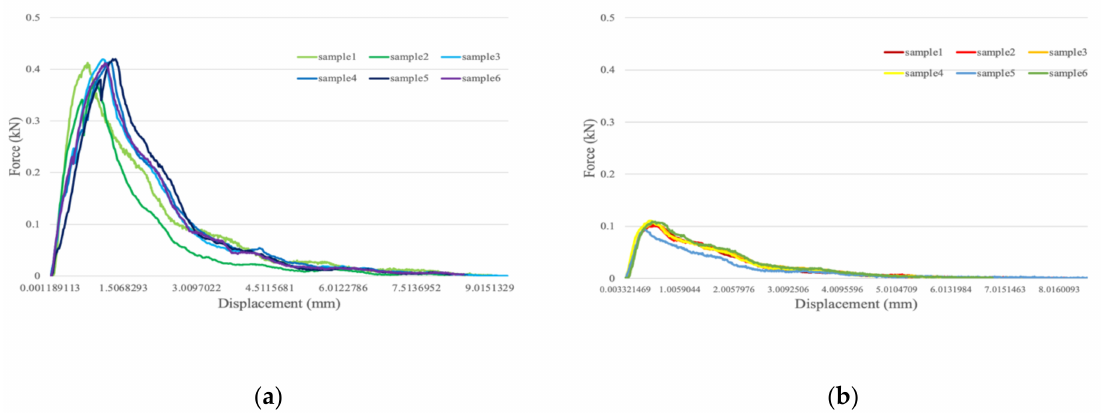
Figure 12. Force–displacement curves of pullout testing in ( a ) 20 PCF ( b ) 10 PCF